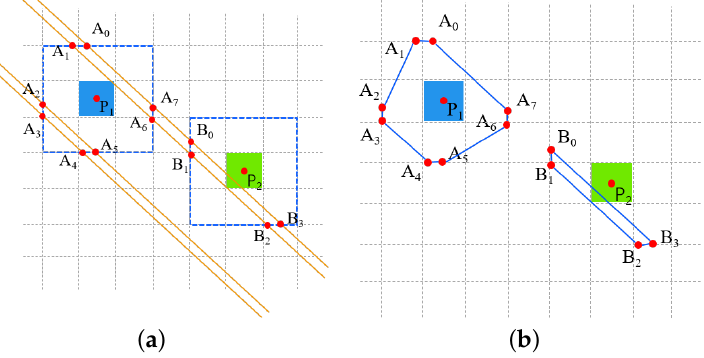
Figure 11. The removal of the faker pylon. ( a ) The simplified distribution figure of power lines and pylon after horizontal projection. ( b ) The convex polygon around the cells of P 1 and P 2